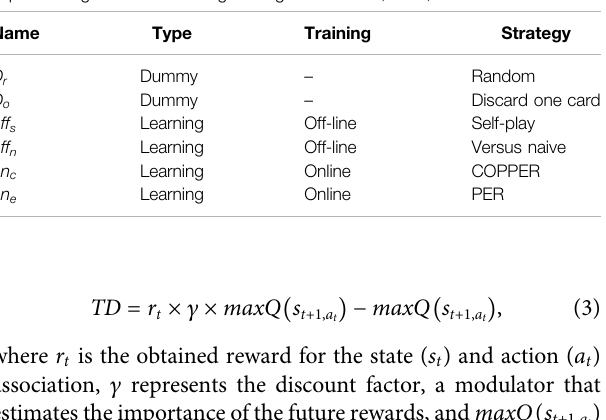
TABLE 1 | Structure of the Chef ’ s Hat Players Club containing a total of 14 different agents: two dummy agents and 12 learning agents, each of them implementing the listed learning strategies with DQL, PPO, and